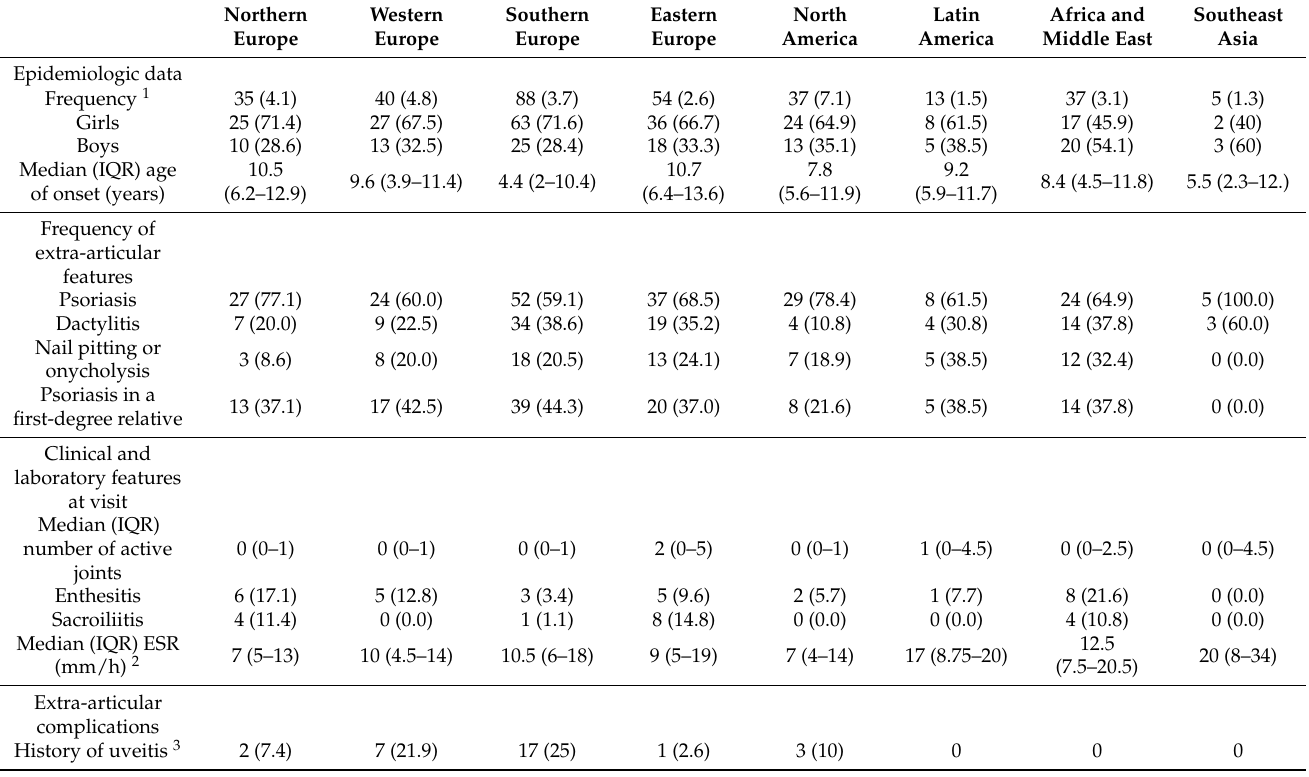
Table 3. Demographic and clinical features of patients with JPsA enrolled in the EPOCA study